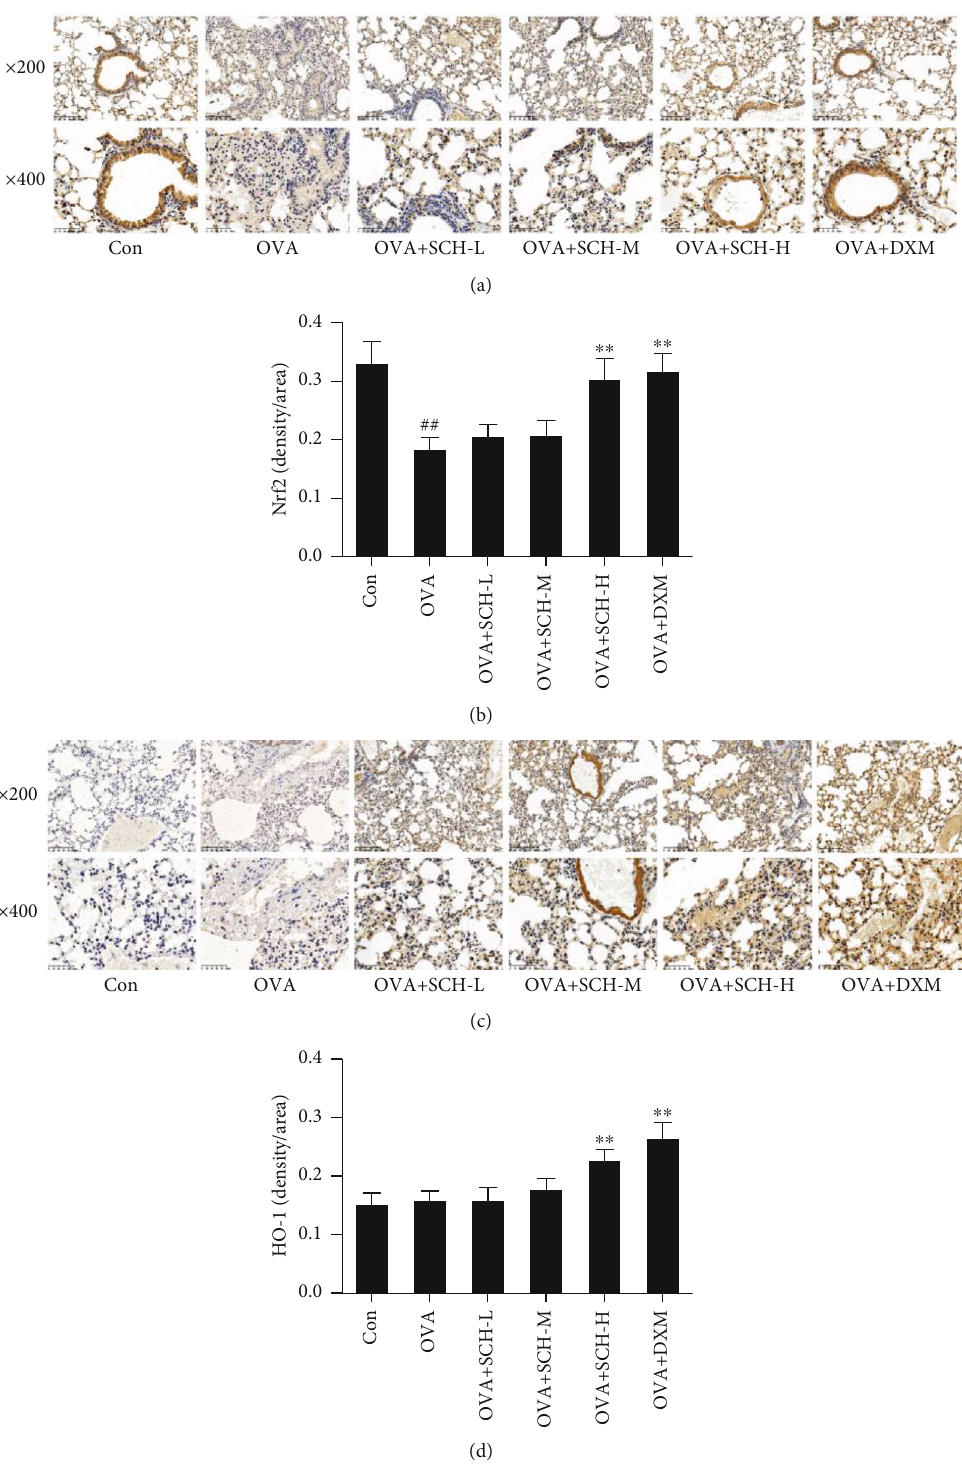
Figure 10: E ff ect of SCH on the expression of Nrf2 and HO-1. (a and c) The levels of Nrf2 and HO-1 were determined using IHC. (b and d) Quanti fi cation of the average density of Nrf2 and HO-1. Data are reported as the means ± SD ; n = 6 . ## p < 0 : 01 compared with the control group; ∗∗ p < 0 : 01 compared with the OVA